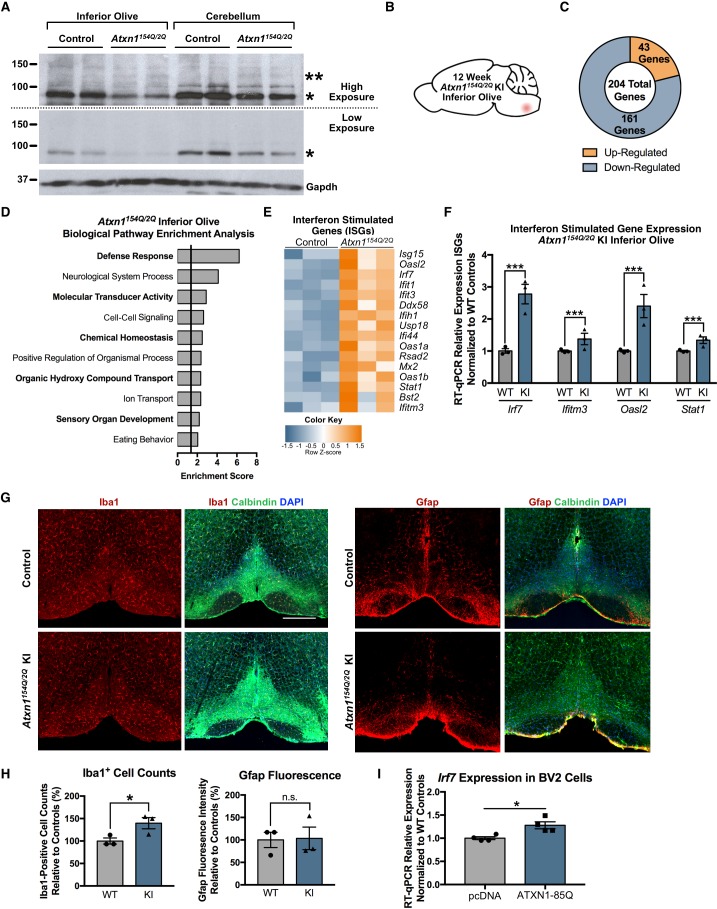
Defense Response-related genes are significantly enriched in the 12 week old Atxn1154Q/2Q KI inferior olive.(A) PolyQ-expanded Atxn1 is expressed in the inferior olive of Atxn1154Q/2Q KI mice (n = 2 animals per genotype). * marks Atxn1-2Q and ** marks Atxn1-154Q. (B) Illustration of the brain region examined. (C) Total number of up- and down-regulated genes in the Atxn1154Q/2Q KI inferior olive (FDR p-value < 0.05; n = 3 males per genotype). (D) Biological pathway enrichment for all differentially regulated inferior olive genes. X-axis marks enrichment score, with the significance cut-off marked by the vertical black line (p-value < 0.05), in this and all following graphs unless mentioned otherwise. (E) Interferon Stimulated Genes (ISGs) are significantly up-regulated in Atxn1154Q/2Q KI. Orange coloring marks up-regulated genes. (F) Validation of up-regulated ISGs in 12 week old Atxn1154Q/2Q KI inferior olive using RT-qPCR. All samples normalized to Gapdh and Actb reference genes. n = 3 males per group. *** p-value < 0.001. Error bars indicate SEM in this and all following graphs. (G) Immunofluorescence staining for Iba1-positive cell counts and Gfap fluorescence intensity imaged in the 12 week old Atxn1154Q/2Q KI and WT control inferior olives. Scale bar is 300 µm. (H) Iba1 cell body counts and Gfap fluorescence intensity quantified relative to WT controls as a percentage. *p < 0.05; t-test; n.s. = non significant (n = 3 males and females per genotype). (I) Irf7 mRNA expression is significantly up-regulated in BV2 cells expressing human ATXN1-82Q (*p < 0.05, t-test; n = 4 wells per condition).10.7554/eLife.39981.008Figure 2—source data 1.5 week old Atxn1154Q/2Q KI inferior olive functional annotation clustering enrichment analysis.10.7554/eLife.39981.009Figure 2—source data 2.Functional annotation enrichment analysis for the 12 week old Atxn1154Q/2Q KI inferior olive.10.7554/eLife.39981.010Figure 2—source data 3.Upstream regulators for differentially regulated 12 week old Atxn1154Q/2Q KI inferior olive genes.10.7554/eLife.39981.011Figure 2—source data 4.5 week old Atxn1154Q/2Q KI inferior olive enriched pathways for cross time-point overlap with EnrichmentMap (enrichment FDR p-value < 0.05).10.7554/eLife.39981.012Figure 2—source data 5.12 week old Atxn1154Q/2Q KI Inferior Olive enriched patwhays for cross-time point overlap with EnrichmentMap.